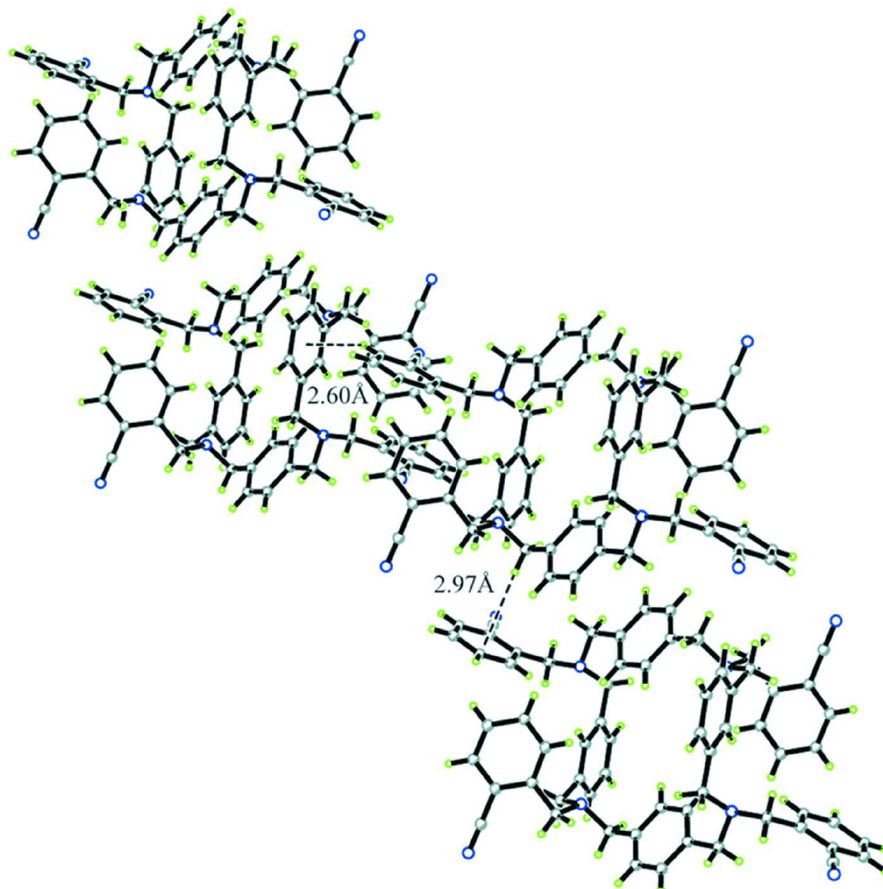
Figure 2 The C—H··· π interactions in